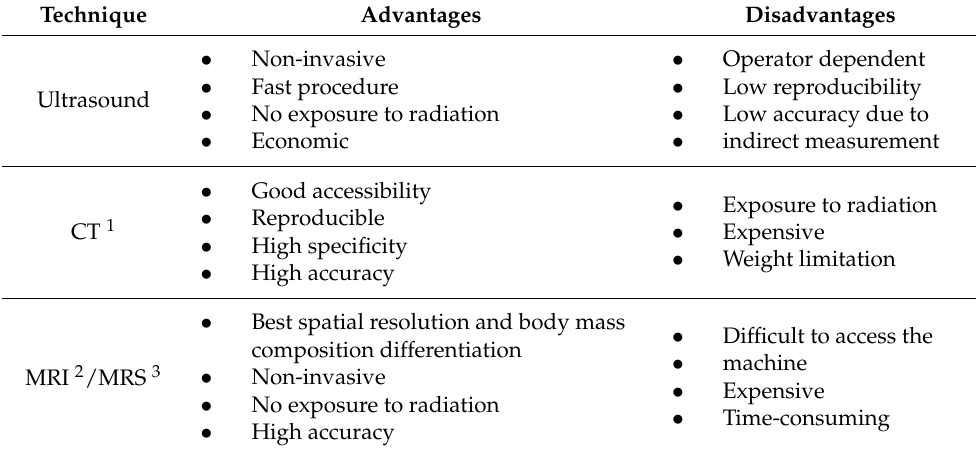
Table 1. Techniques for measurement of pancreatic and liver